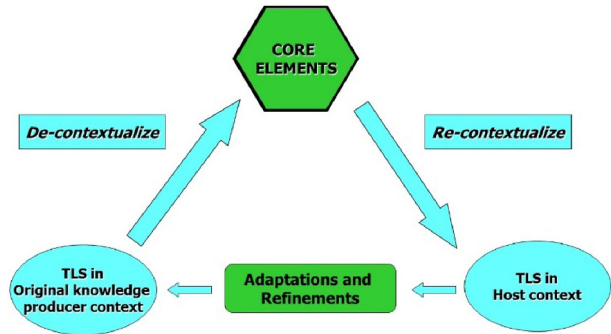
FIG. 2. Graphical representation of the modified ARI model to frame TLS transfer